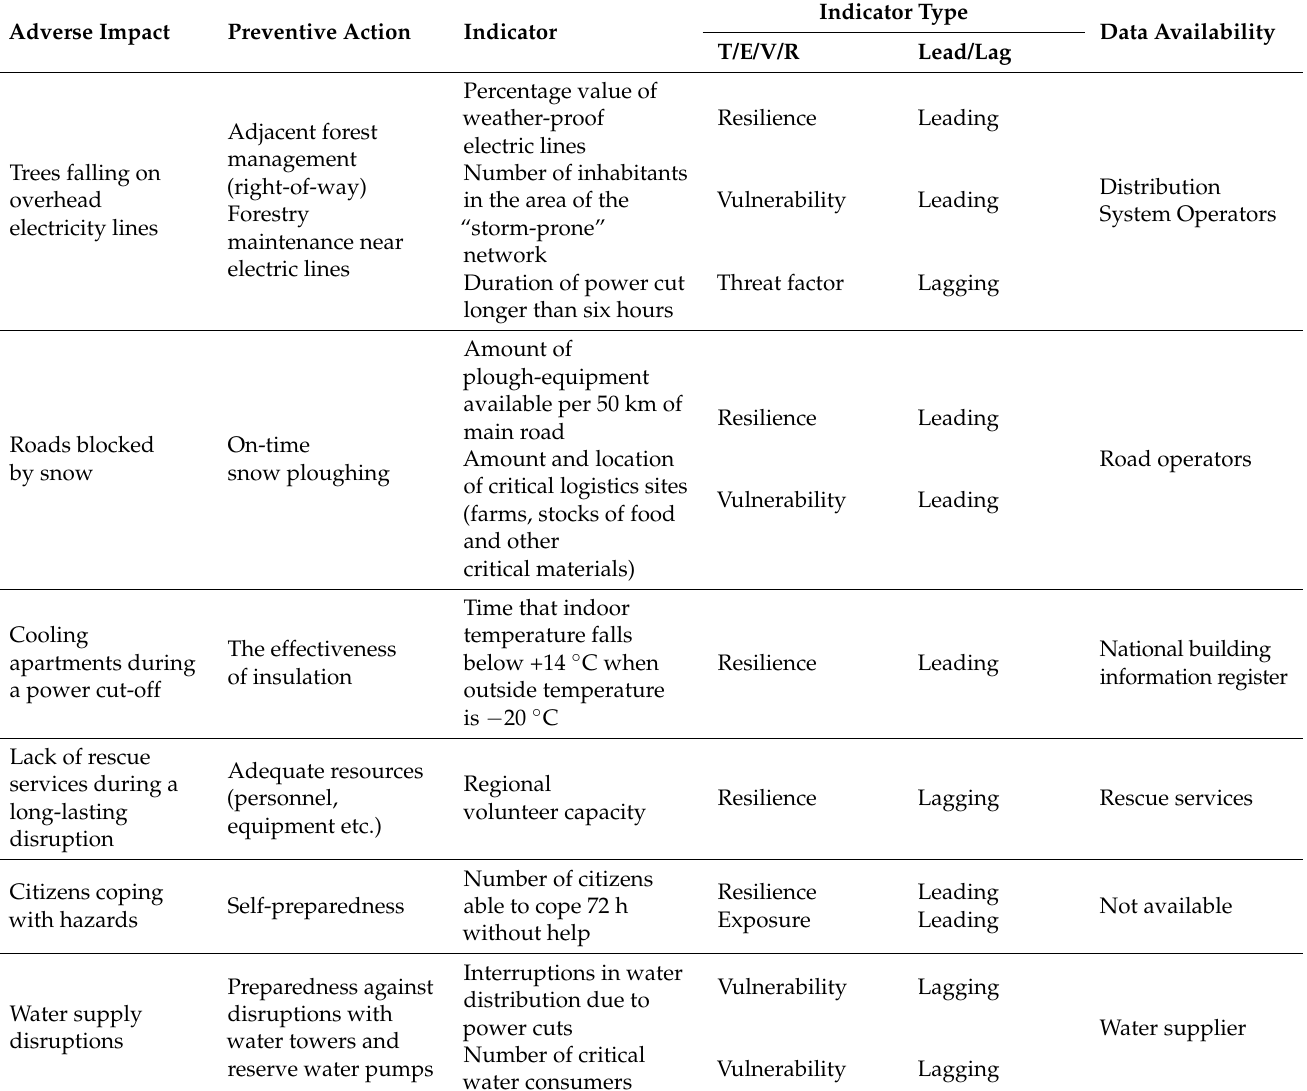
Table 3. Indicators identified in the